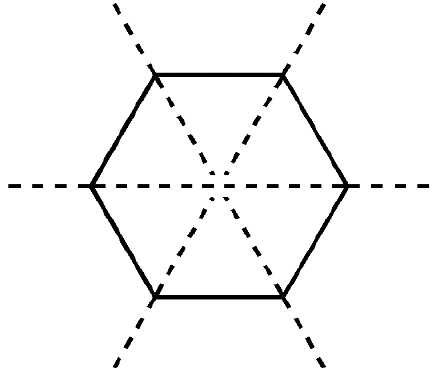
Figure 10. Pseudo mirror planes related to Δ C s. Table 7. Calculated asymmetry parameter values in studied